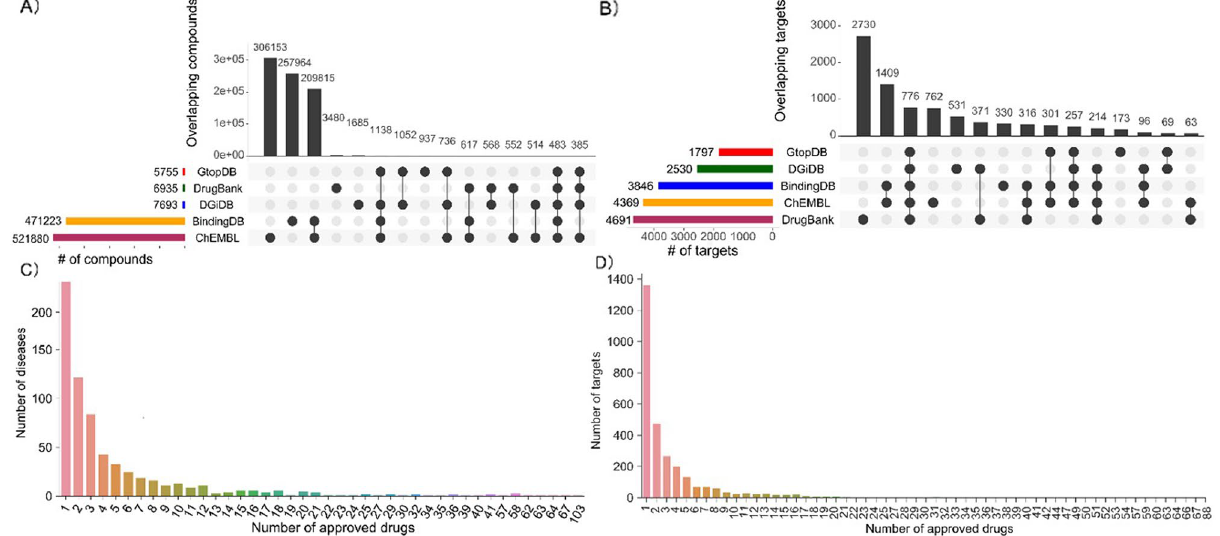
Figure 2. ( A ) Number of overlapping compounds across five databases. ( B ) Number of overlapping targets between five databases. ( C ) Distribution of diseases across 1091 approved drugs. ( D )Target coverage across 1091 approved